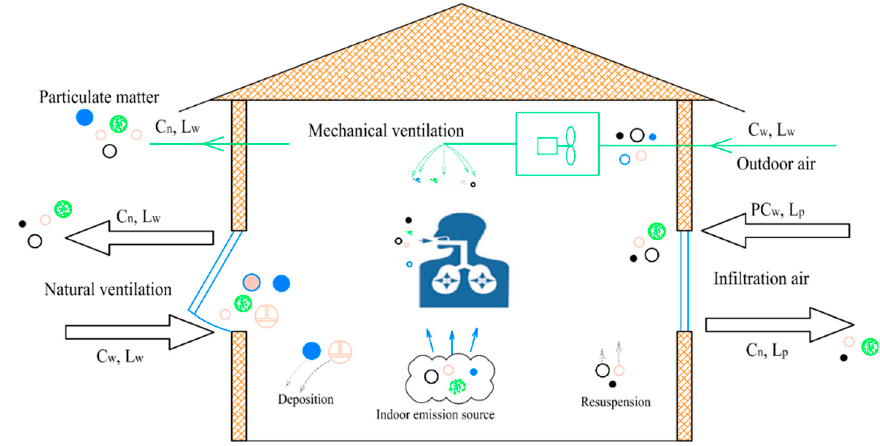
Figure 4. Schematic Map of PM2.5 Sources in Building.